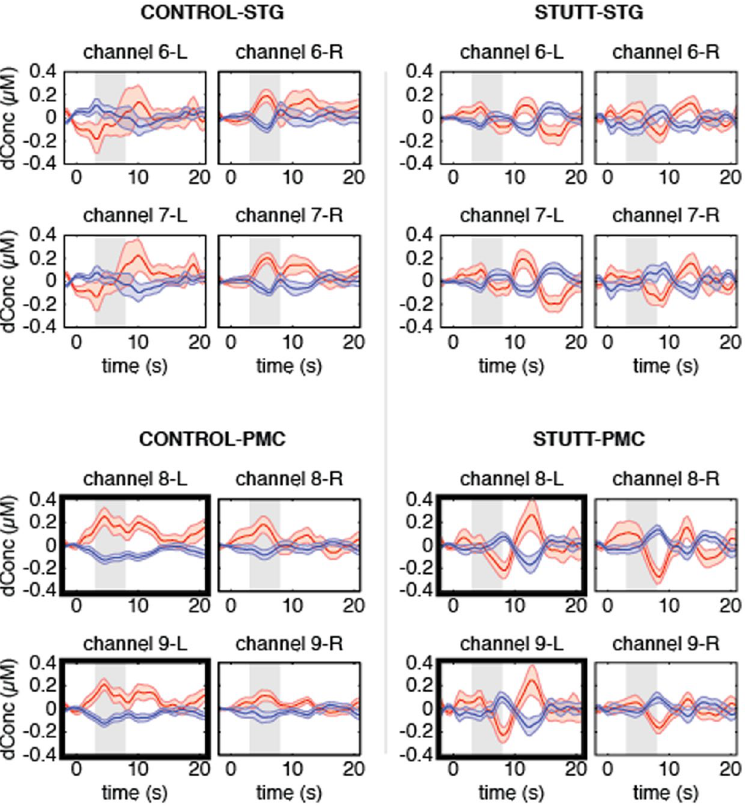
Figure 2. Grand averaged Oxy-Hb (red) and Deoxy-Hb (blue) hemodynamic responses with standard error curves for STG (top plots) and PMC (bottom plots) channels. Channels for the controls (n = 16) are shown on the left hand side of this figure and channels for the children who stutter (n = 16) are plotted on the right. Within each participant group, left hemisphere channels are plotted side-by-side with homologous right channels for comparison. Channels showing a significant group difference are bold-framed. Time = 0 indicates trial onset. Gray shading indicates the 3–8 s. window of analysis.